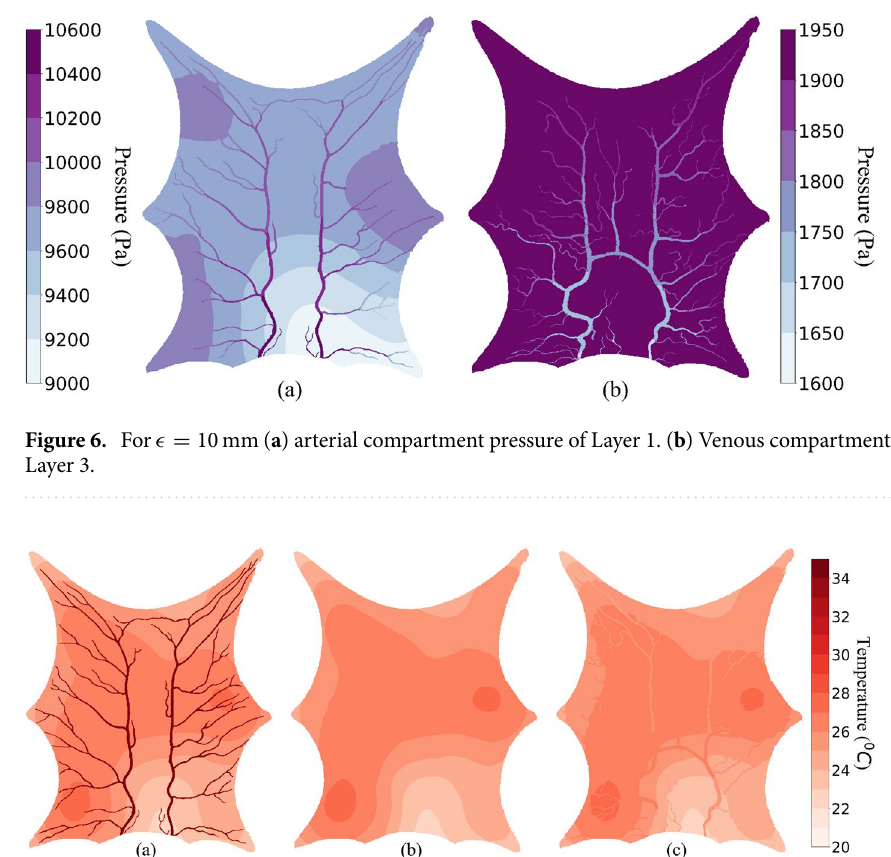
Figure 7. Thermal map using PBM assumption h b = 0.001 W / m ( c ) Layer